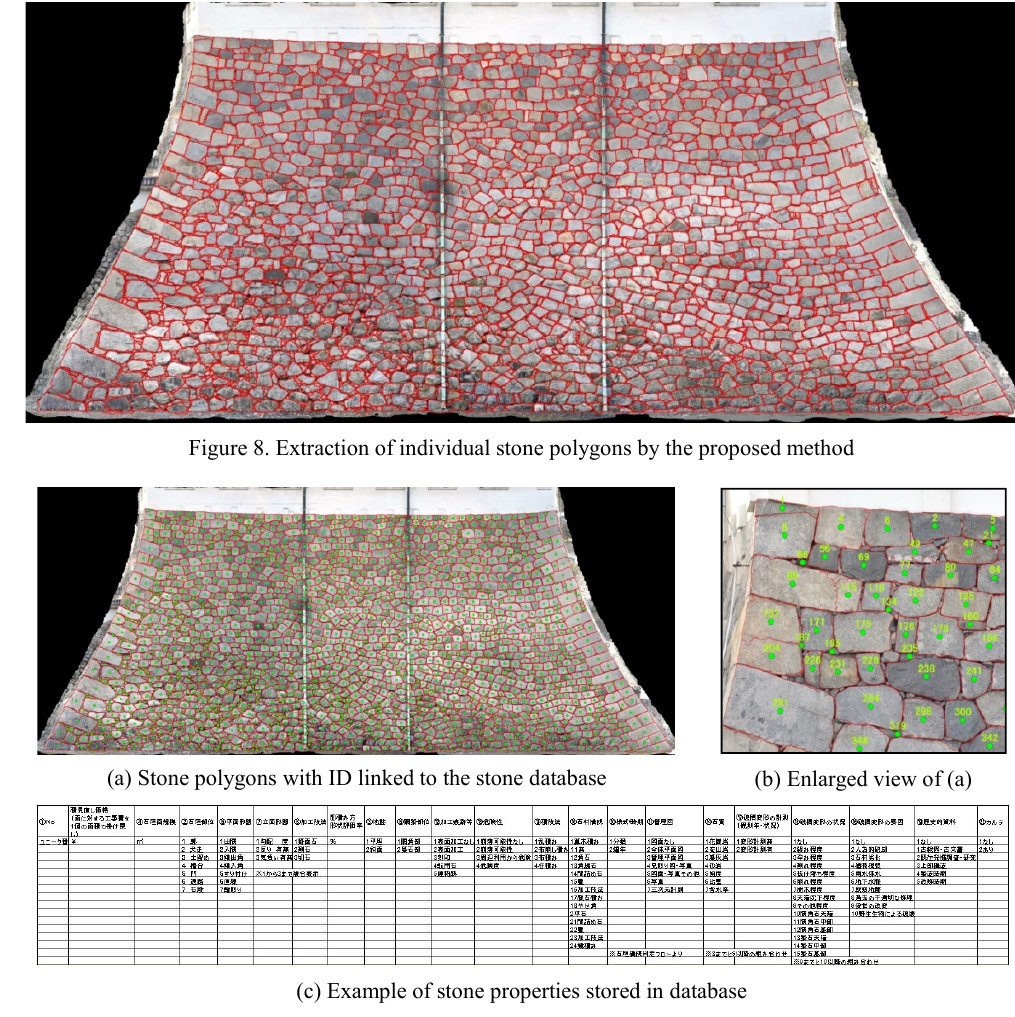
Figure 9. Example of stone management database